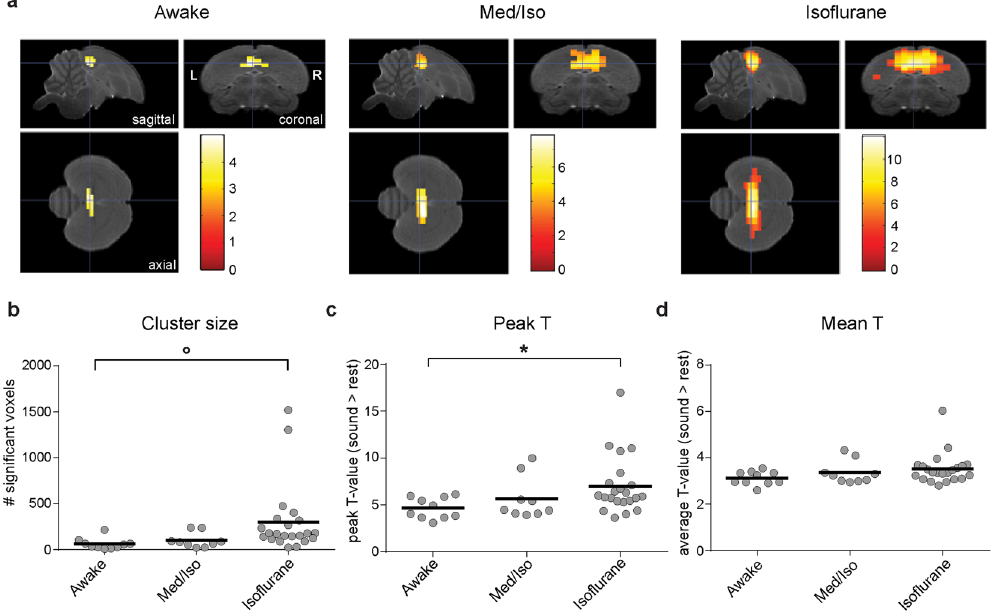
Figure 3. BOLD responses in the zebra finch auditory forebrain in response to sound (vs rest) for the different conditions. ( a ) The images represent results of the voxel based group analysis for all sounds > rest (one-tailed t-tests) in awake, Med/Iso anaesthetized or isoflurane anaesthetized conditions. T -values are colour coded according to the scale next to the figures and only voxels with T -values > 3.32 ( p uncorrected < 0.001) are displayed. The statistical maps are superimposed on images from the population based template. ( b – d ) The graphs illustrate the cluster size ( b ), peak T ( c ) and mean T ( d ) of the activated cluster within the auditory forebrain in response to sound in awake, Med/Iso anaesthetized and isoflurane anaesthetized conditions. Individual measurements are depicted by grey circles and the group mean by the black line ( * p < 0.05; ° p <